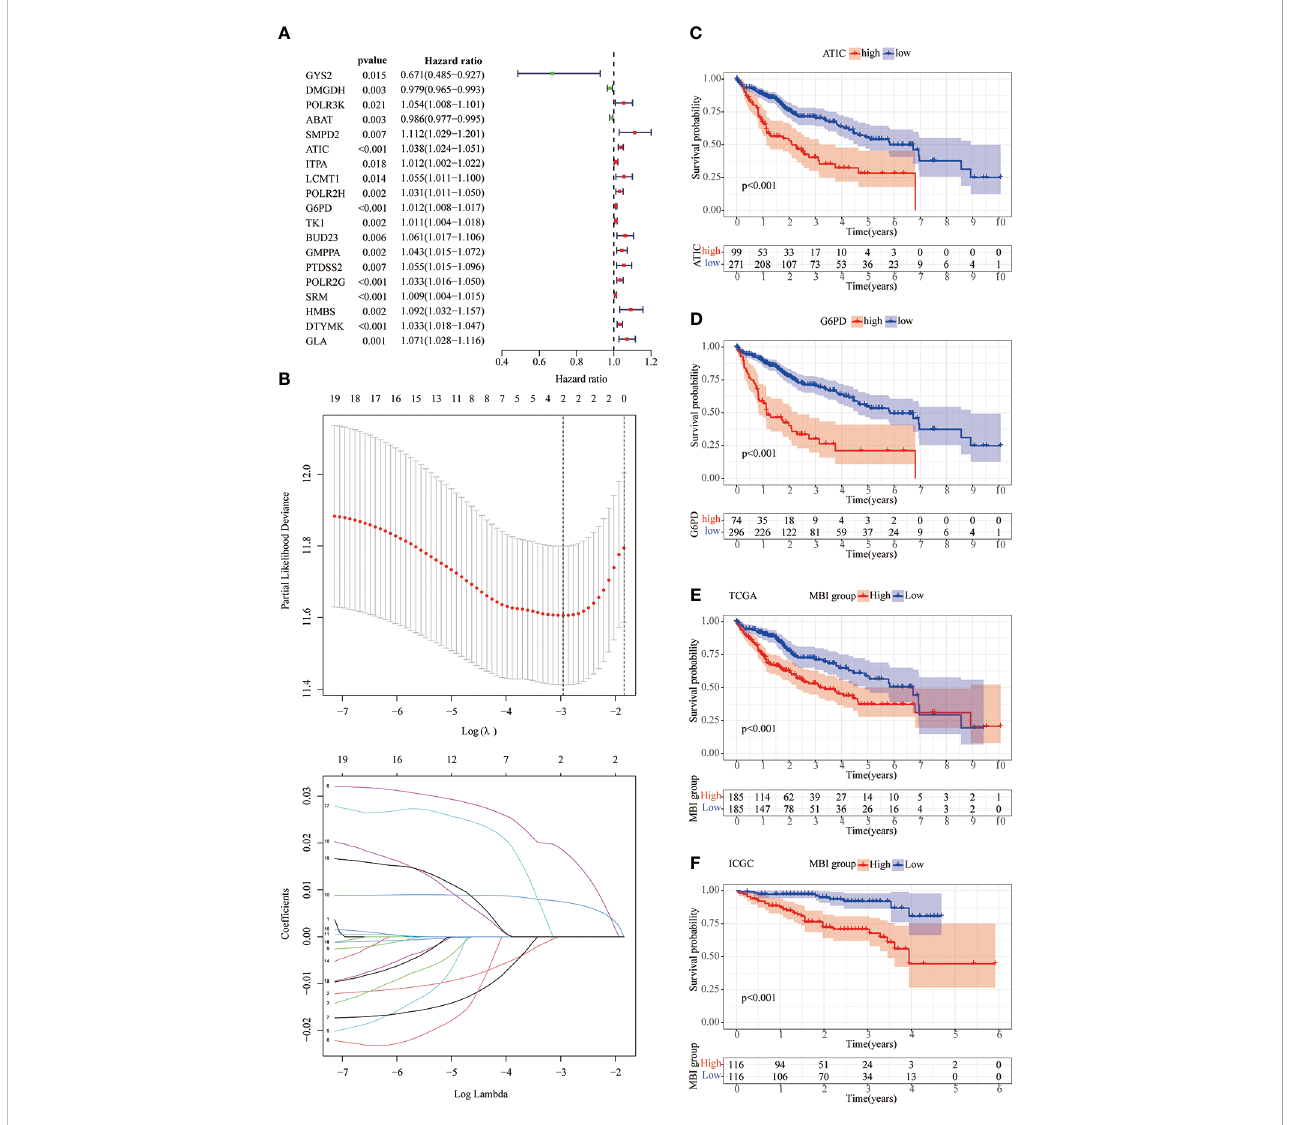
FIGURE 3 Lasso regression model and KM prognostic analysis. (A) Univariate COX prognostic analysis revealed genes with prognostic value. (B) The LASSO regression model calculated the best lamda value of 2 and selected the best modeled genes. (C, D) KM analysis shows poorer prognosis when both ATIC and G6PD are genes with high expression. (E, F) In the TCGA and ICGC databases, KM analysis identi fi ed a poorer prognosis in the high MBI